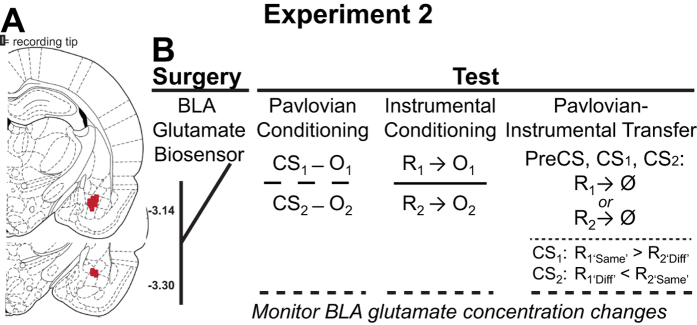
Experiment 2 Design.(A) Schematic representation of the placement of the microelectrode array biosensor tips. Numbers to the lower right of each section represent the anterior-posterior distance (mm) from bregma of the section. (B) Testing procedures (see methods). CS, conditioned stimulus; O, outcome/reward; R, instrumental lever-press response; Ø, no reward delivery. During the PIT test both levers were available, but pressing was not reinforced and each CS was presented 4 times with intervening no-cue (Pre-CS) periods. During the CS presentation actions on the lever that, during training, earned the same outcome as the cue predicted were considered ‘same’ presses, while actions on the other lever were considered ‘different’ (Diff) presses. BLA glutamate concentration changes were continuously monitored with constant potential amperometry at glutamate biosensors during each test.